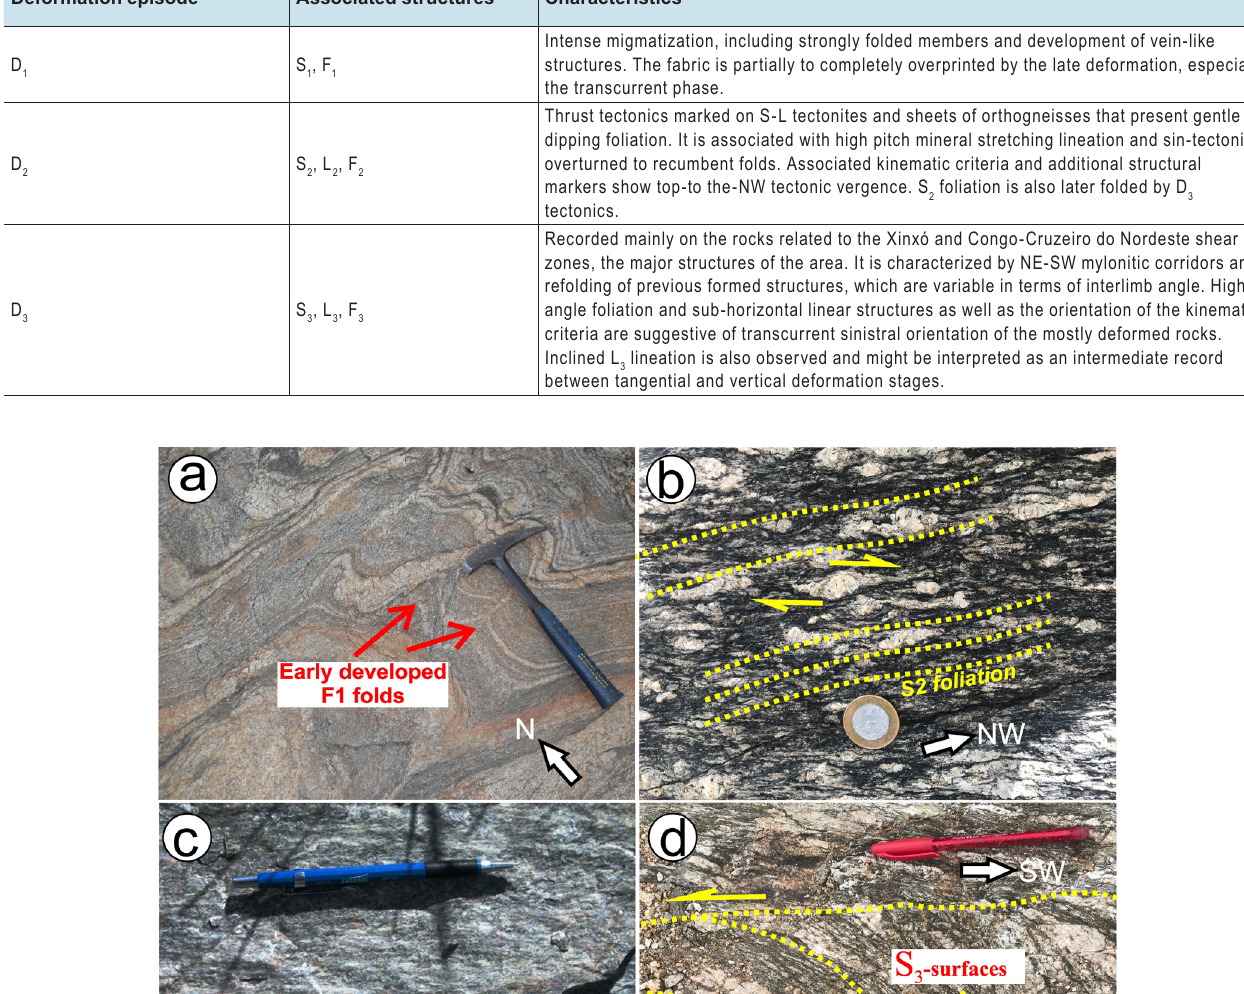
TABLE 1 - General description of the deformational evolution of the studied area. Deformation